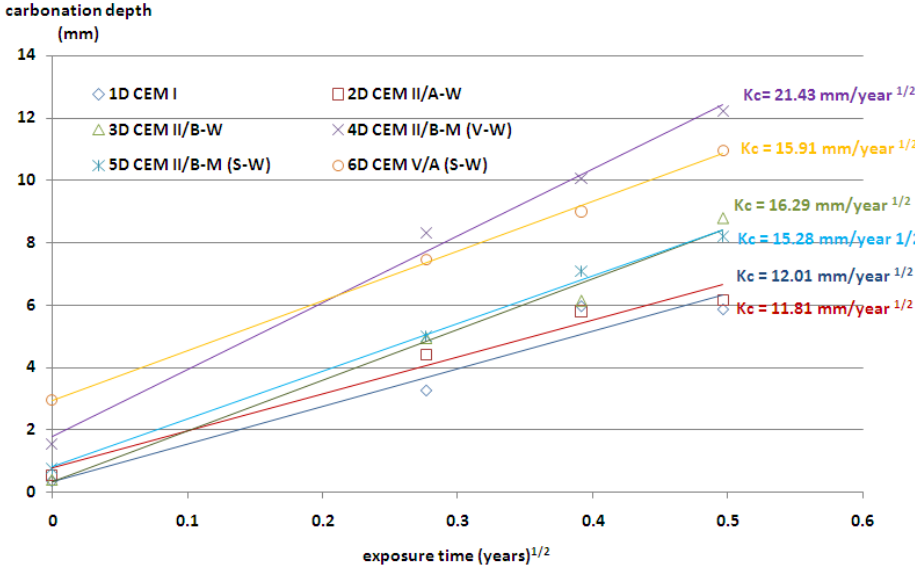
Figure 4. Depth of carbonation as a function of the square root of time (the values of K c coefficient); limestone aggregate.